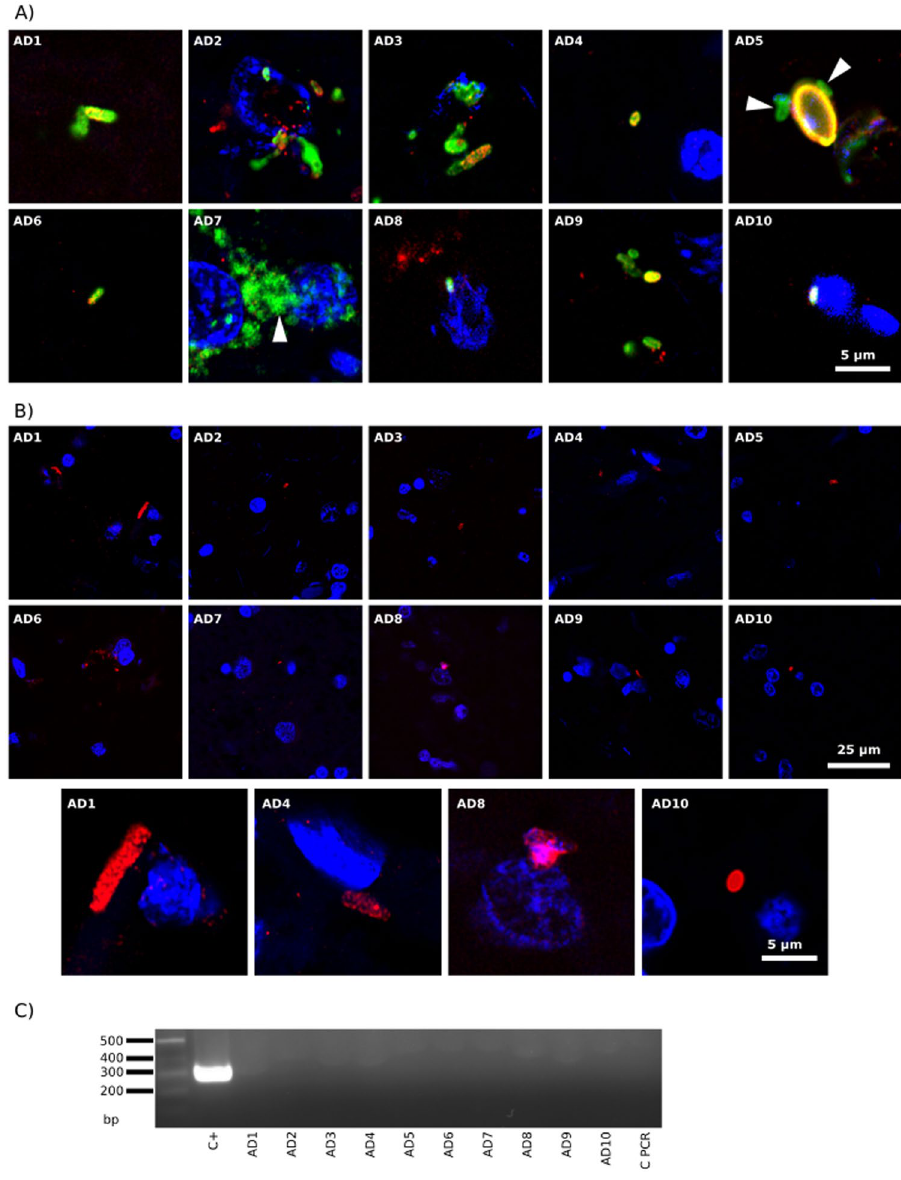
Figure 2. Detection of Borrelia proteins and DNA in ERH samples from ten AD patients. PCR assay of B. burgdorferi DNA. Panel A: ERH sections were immunostained with rabbit polyclonal antibody (1:50) against B. burgdorferi (green) and rat polyclonal antibody (1:20) against T. viride (red). Panel B: ERH sections were immunostained with mouse monoclonal antibody (1:10) against B. burgdorferi (green) and rabbit polyclonal antibody (1:100 dilution) against C. albicans (red). DAPI staining of nuclei appears in blue. Scale bar as shown in the figure. Panel C: PCR analysis of Borrelia DNA in frozen brain tissue from ten AD patients. Nested PCR analysis of ten ERH samples using Borr primers to amplify flagellin gene. The primers employed were Borr FE– Borr RE for the first PCR and primers Borr FI–Borr RI for the second PCR. As positive control, DNA extracted from B. burgdorferi was used. Control PCR: PCR without DNA. DNA markers are indicated on the